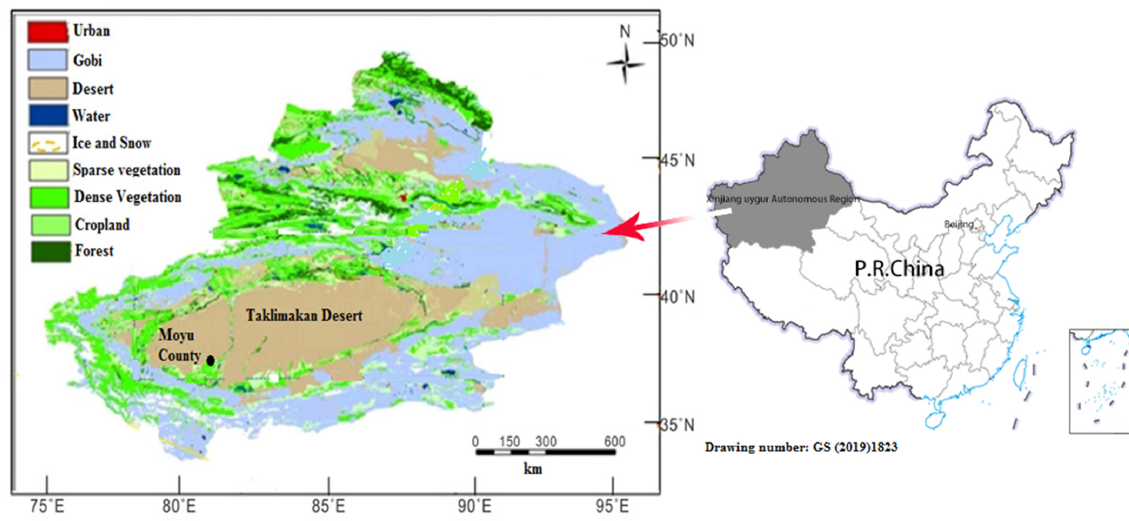
Figure 1. Location and surrounding environment of the study area.